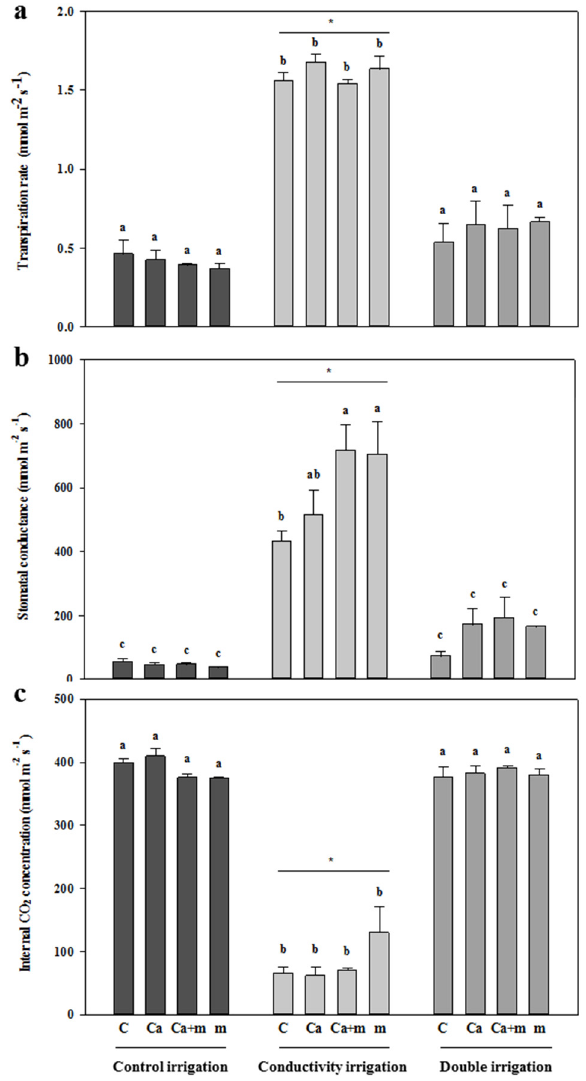
( a ) transpiration rate (mmol m − 2 s − 1 ), ( b ) stomatal conductance (mmol m − 2 s − 1 ), and ( c )